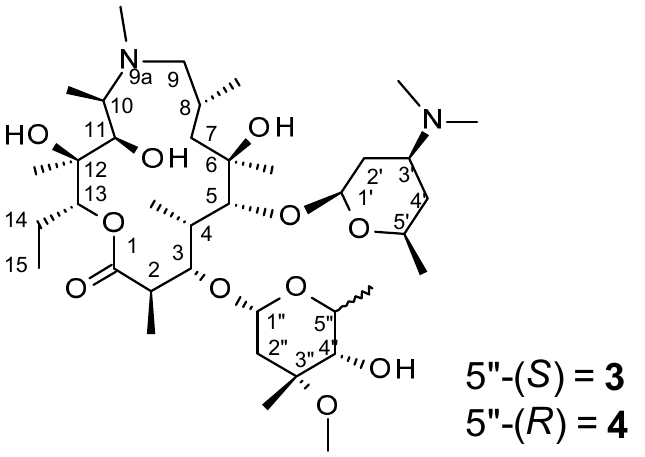
Scheme 1. Reagents and conditions: ( a ) O -phenyl thionochloroformate, NaHCO 3 , toluene, 60 °C, 2 h; ( b ) see Table 1. Table 1. Radical deoxygenation conditions (toluene was used as solvent in all reactions). Radical Quench/Eq. Radical Initiator/Eq. Concentration (Mol/L) Temperature (° C) Ratio of 3:4 Bu 3 SnH/1.2 4 of 12 Table 2. Comparison of 3 J H,H (Hz) coupling constants for 3 and 4 in D 2 O at 25 °C; differences marked in bold. Atom